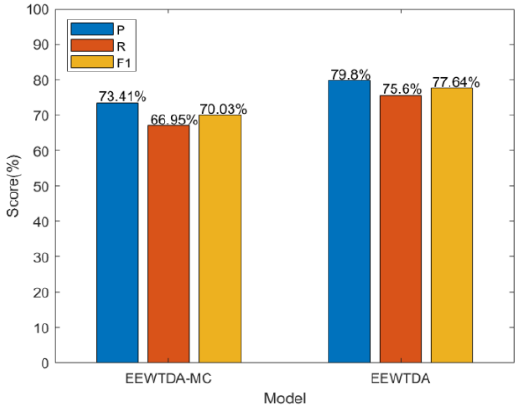
Figure 6. Comparative experiment of EDWTDA-MC and EDWTDA.